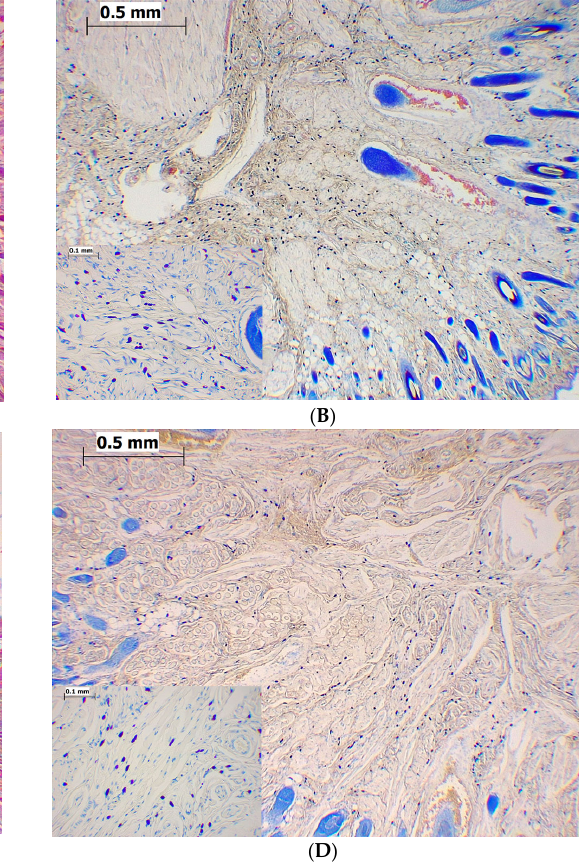
Figure 6. The effect of magnesium sulfate (MS) on the total ( a ) and degranulated ( b ) number of mast cells in the upper lip dermis in the formalin orofacial test in rats. Each bar represents the average number of total or degranulated mast cells per high representative field (HRF) ± SD obtained from 6 rats. Mast cells counted pathohistologically by toluidine blue staining at high magnification (400×), before (naive rats; n = 6) and after (5 min, 25 min, and 24 h ) injection of formalin (6 rats per 3 time points; n = 18) with/without magnesium (6 rats per 3 time points; n = 18) or 0.9% NaCl (6 rats per 3 time points; n = 18). ( a ) Statistical significance (two ‐ way ANOVA followed by Tukey’s HSD) was determined by comparing with naive rats (* p < 0.05, ** p < 0.01), ++ p < 0.01 in comparison with 0.9% NaCl, # p < 0.05 in comparison with formalin. ( b ) Statistical significance (two ‐ way ANOVA followed by Tukey’s HSD) was determined by comparing with naive rats (** p < 0.01), + p < 0.05, ++ p < 0.01, respectively, in comparison with 0.9% NaCl, ## p < 0.01 in comparison with formalin.